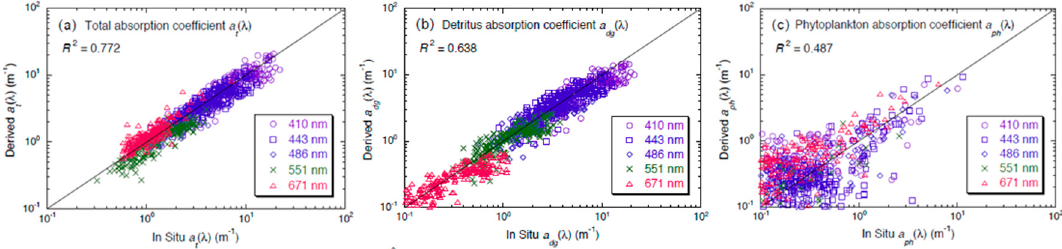
Figure 3. Comparisons of the near-infrared (NIR)-based inherent optical property (IOP) retrievals and in-situ measurements at the Visible Infrared Imaging Radiometer Suite (VIIRS) spectral bands for IOP of ( a ) a t ( λ ), ( b ) a dg ( λ ), and ( c ) a ph ( λ ). Table 1. Coe ffi cients of determination R 2 between the derived- and in-situ-IOPs in Lake Taihu.